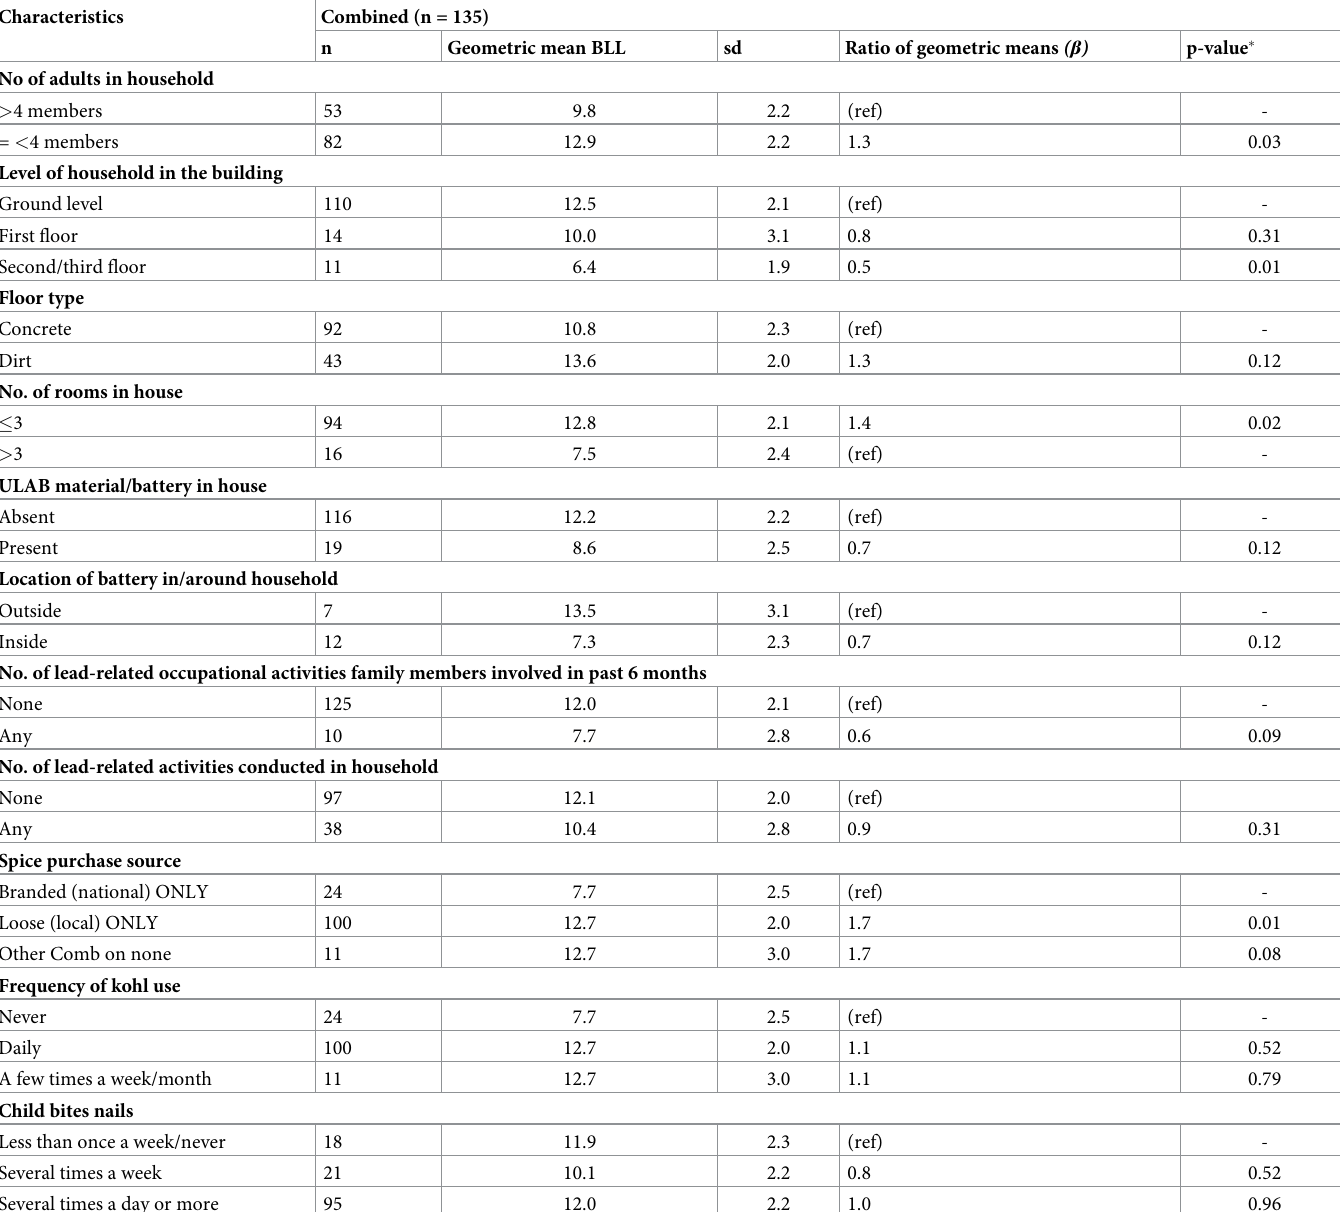
Table 4. Association between BLLs and various risk factors for all children, Patna, Bihar, February 2020.